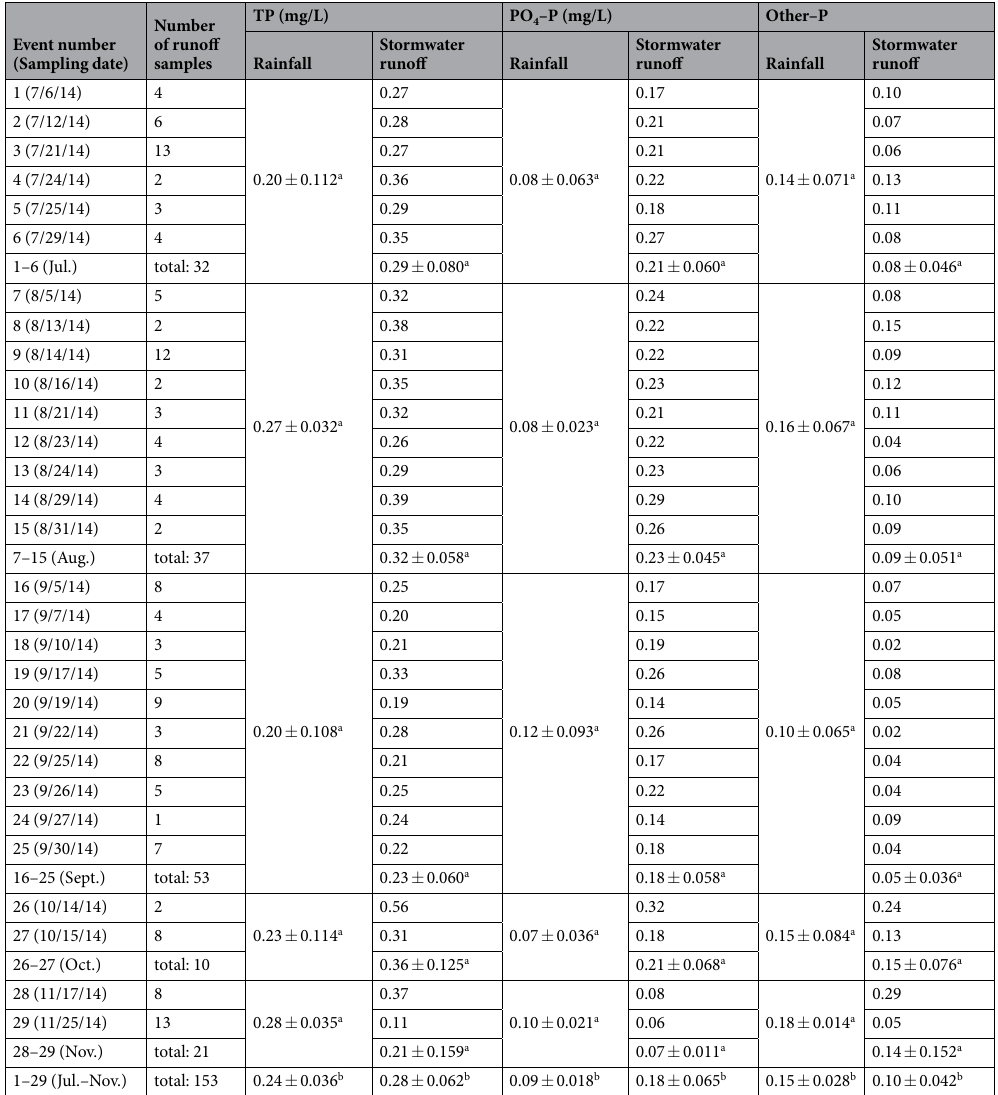
Table 1. Concentrations of phosphorus in rainfall and stormwater runoff collected from individual 29 storm events during July–November 2014. a Monthly mean value ± standard deviation. b Seasonal mean value ± standard